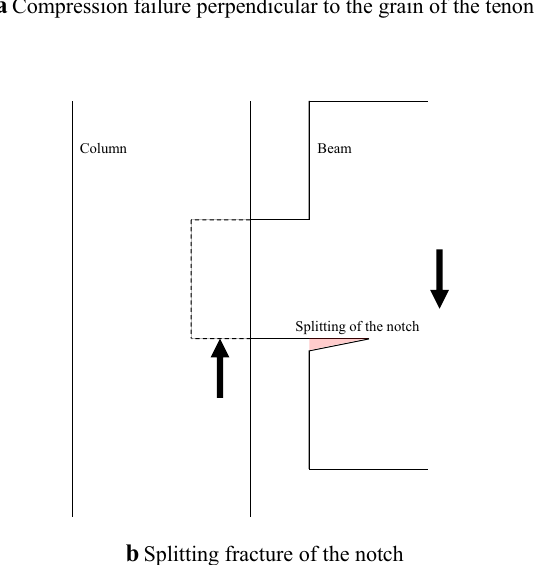
a Compression failure perpendicular to the grain of the tenon